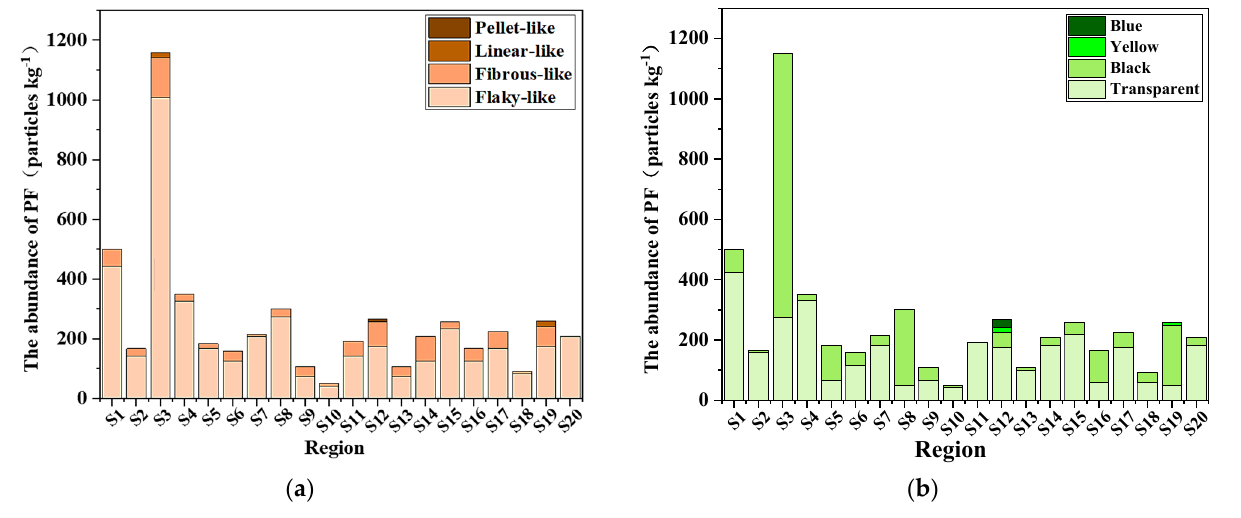
Figure 4. Morphological characteristics of PF in different regions of Sichuan Province. ( a ) Shape distribution of PF in the sample; ( b ) Color distribution of PF in the sample.